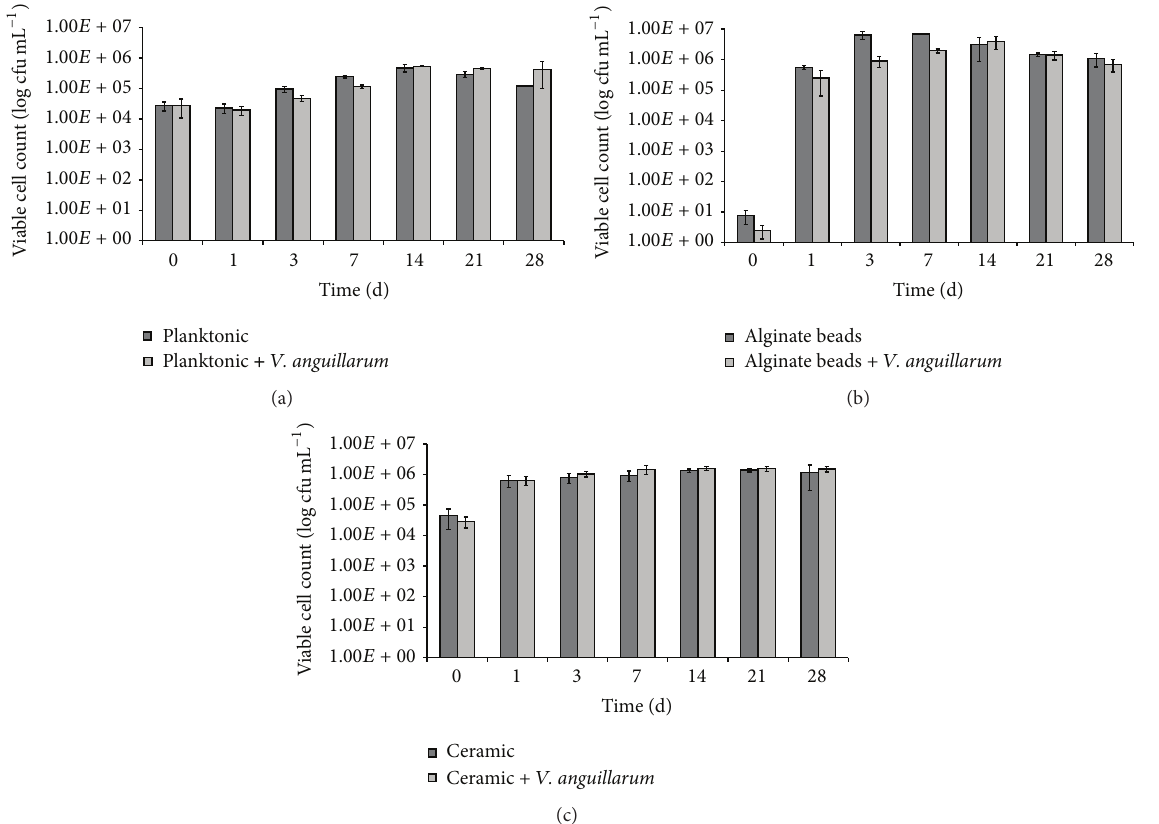
Figure 6: Logarithmic presentation of P. sp. strain MLms gA3 viable cell counts [cfumL −1 ] ((a) planktonic, (b) immobilised in alginate beads, and (c) immobilised as an artificial biofilm on a ceramic tile) in the presence of V. anguillarum (light grey bars) compared to the viable cell counts without V. anguillarum (control, dark grey bars) over a period of 28 days. (a) Initial concentration of planktonic cells was ∼ 10 4 cfumL −1 on day 0. (b) 15 alginate beads were added to each treatment on day 0. (c) One ceramic tile was added to each treatment on day